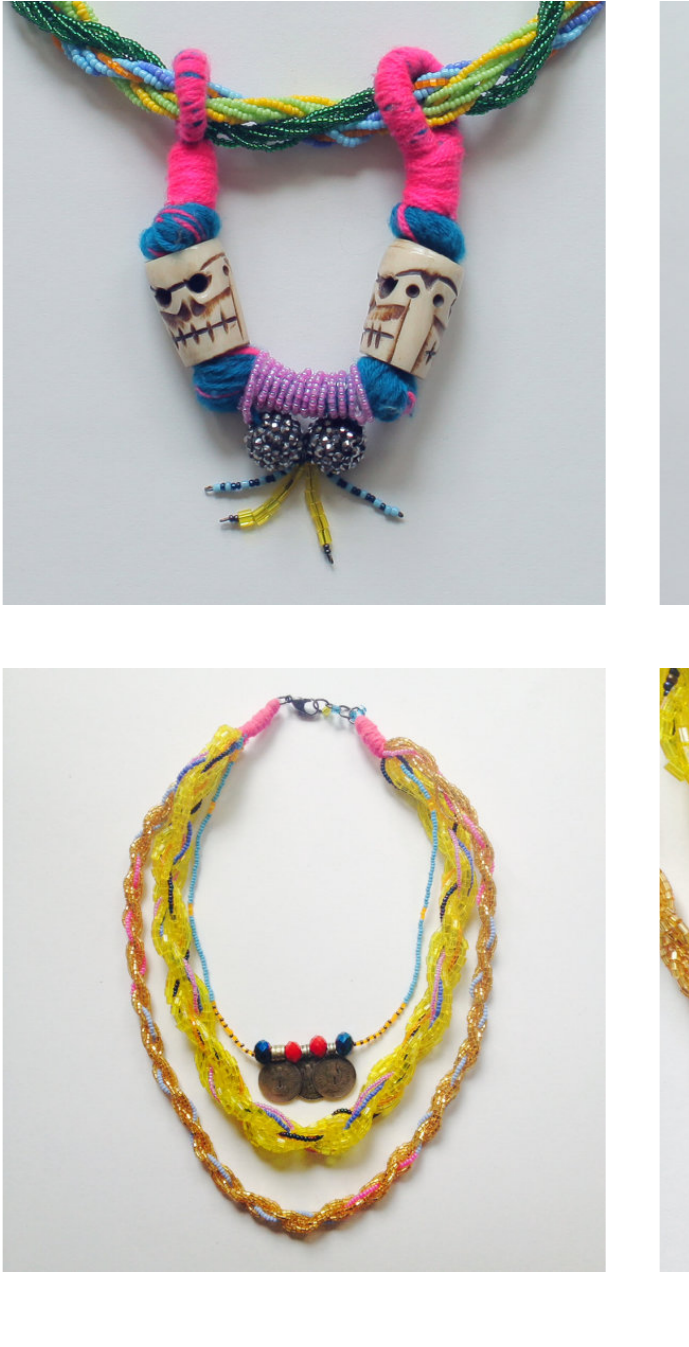
where women are banned from wearing color upon the death of their husband, especially shades of red, is something that has affected me since I was a child. After losing my father, my mother’s decision to wear red was criticized by many people, including women. I see the culture of stripping a woman from wearing color as a practice that is misogynistic and regressive. Color then seems to be a symbol of life, and in a way, not letting a woman wear color is telling her that her life, her identity, is completely linked to her husband’s and therefore, she has no identity for herself. I am a woman, and I will use color whenever I